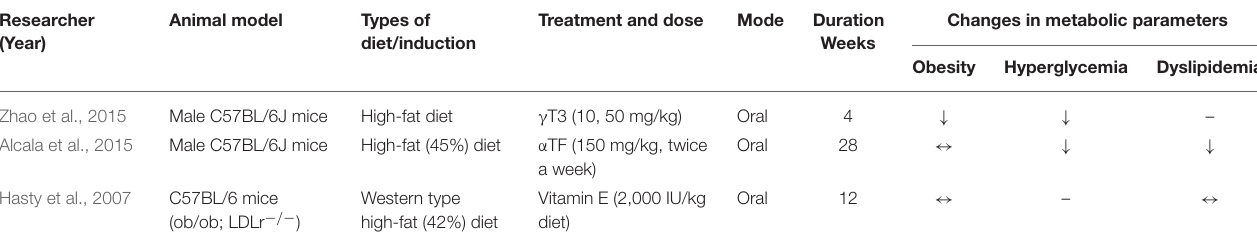
TABLE 1 | The effects of vitamin E on metabolic parameters in obese animal models. Researcher (Year)